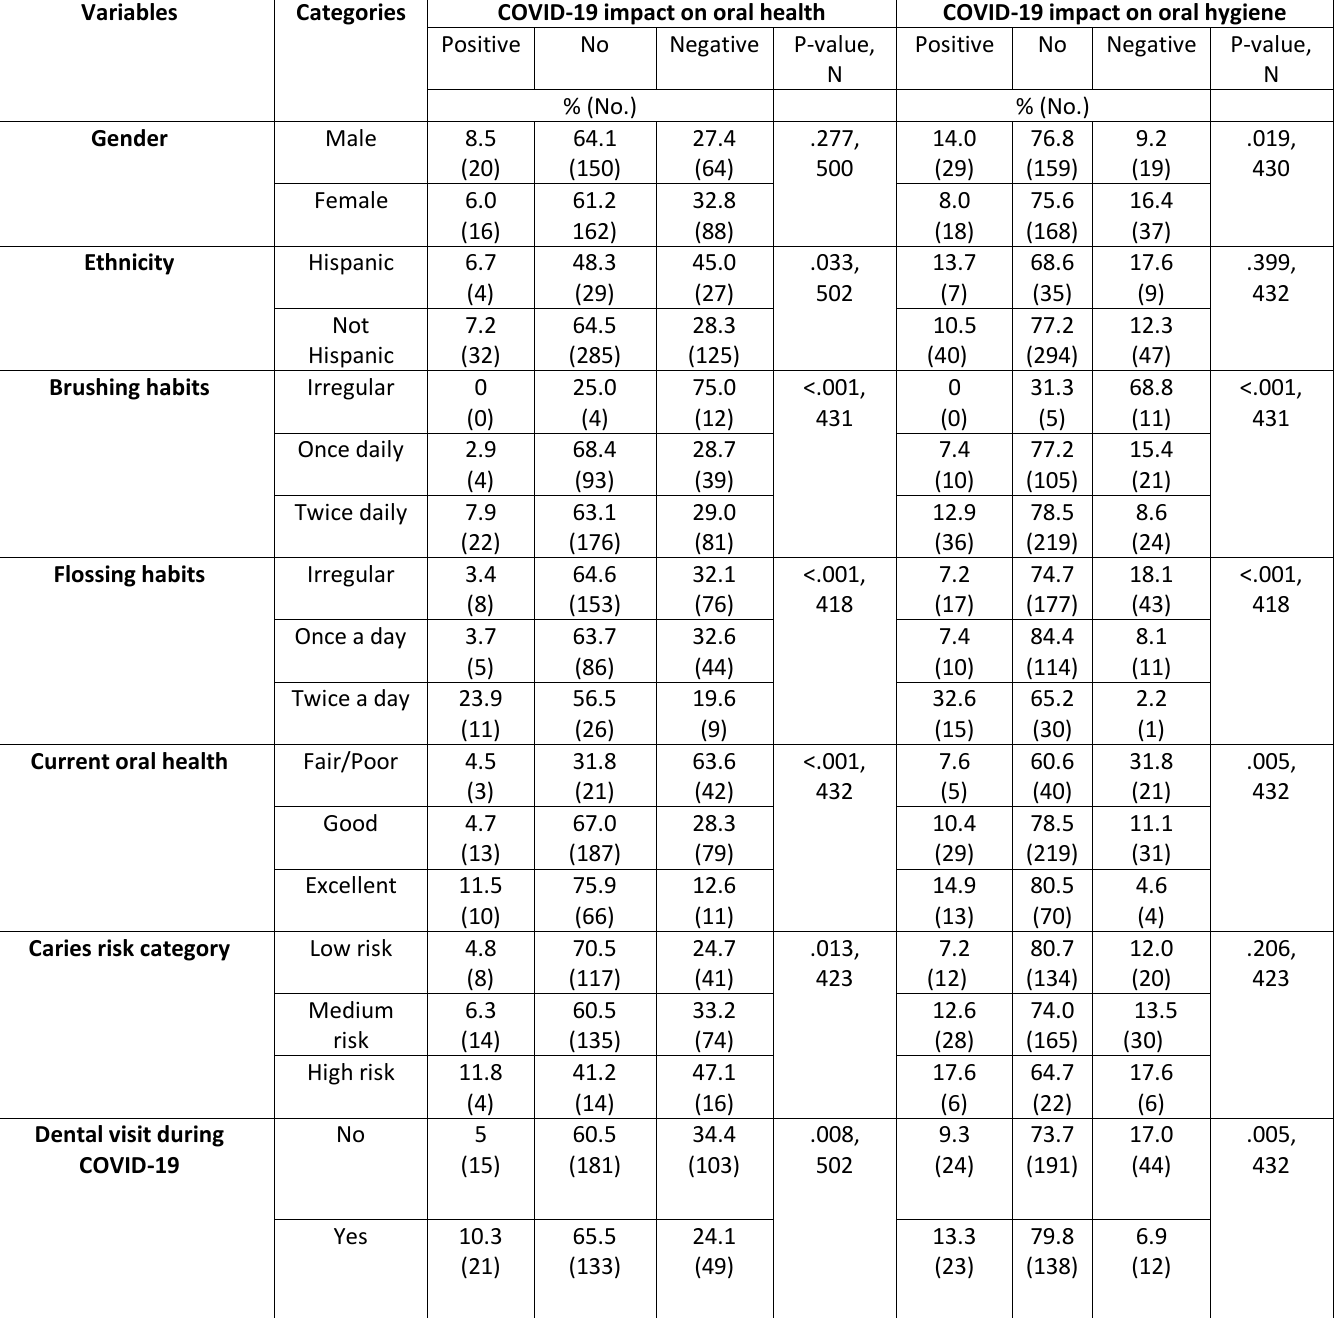
Table 2 Impact of COVID-19 outbreak on oral health and oral hygiene routine cross-tabulated with other